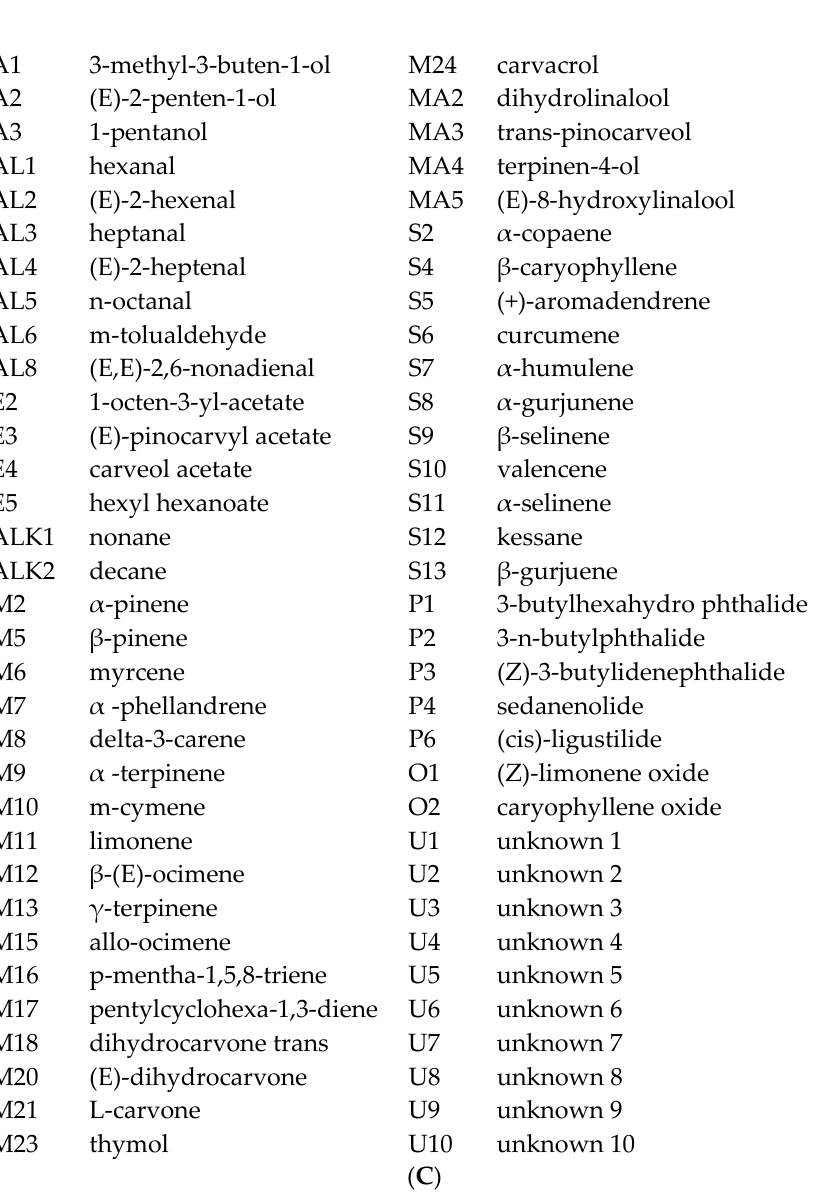
Figure 1. Principal component analysis of eight celery samples harvested in 2018 and 2020 showing correlations with volatile compounds. ( A ) Projection of the samples; ( B ) Distribution of variables; ( C ) Compound codes as appear in plot ( B).